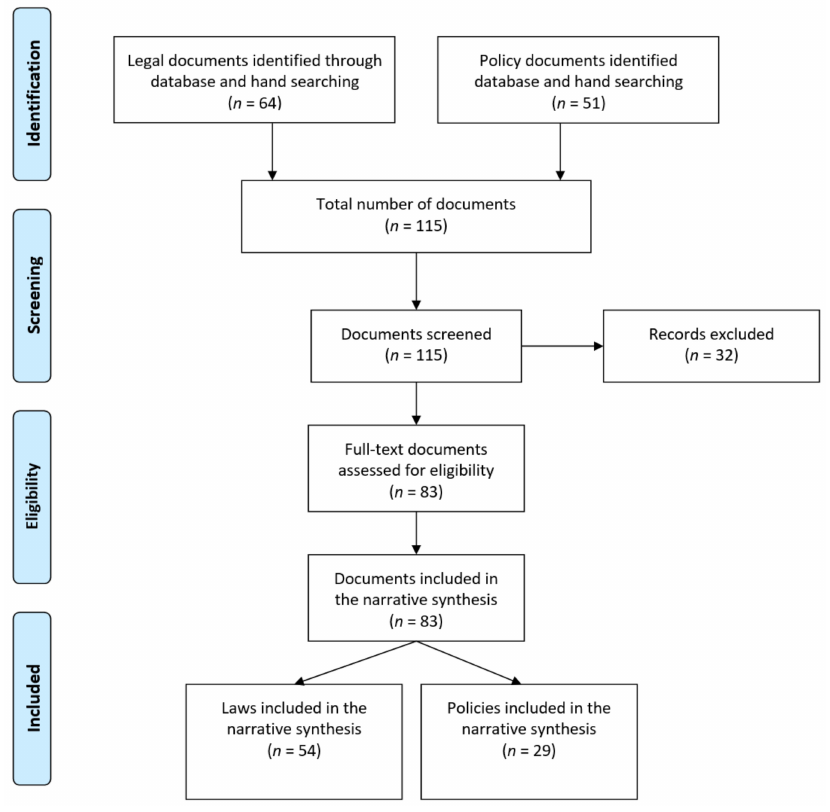
Figure 1. Document identification and selection flowchart